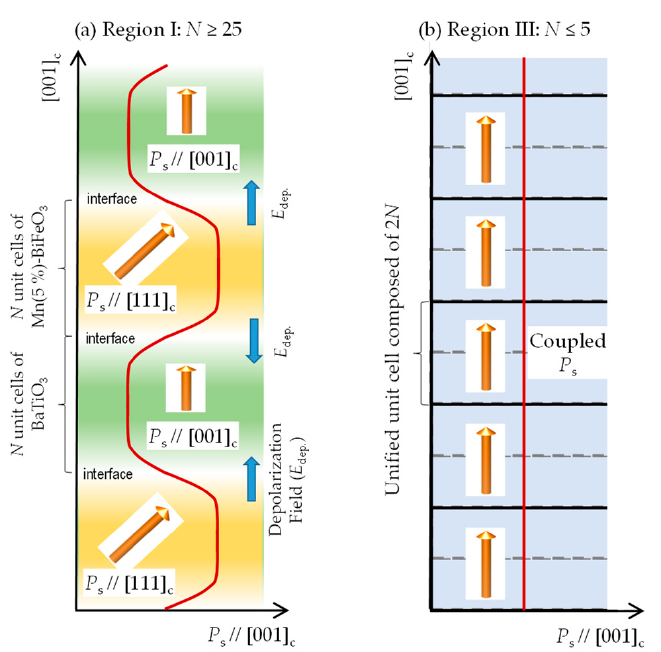
Figure 7. Schematics of the crystal structures of the supercells with ( a ) N ≥ 25, and ( b ) N ≤ 5, along with the [001] c component of P s . In ( a ), the thickness of the layers of Mn-BiFeO 3 and BaTiO 3 is sufficiently thin, and thereby their polarization features are maintained inside them. In ( b ), the structural and electronic coupling of Mn-BiFeO 3 and BaTiO 3 is activated, and the two layers can no longer be distinguished, leading to a unified ferroelectric unit cell.